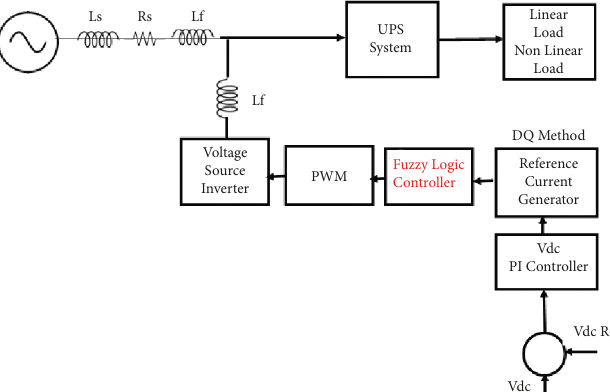
Figure 17: Single-phase half-bridge HAPF based on FLCC for UPS System control block diagram.